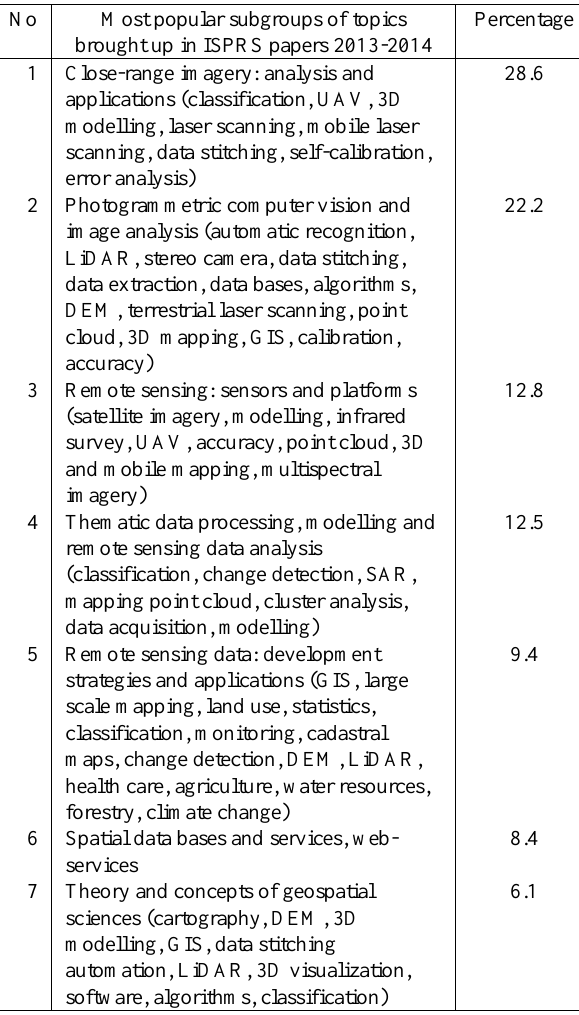
Table 4. Frequency of publications devoted to particular topics in the ISPRS materials 2013-2014